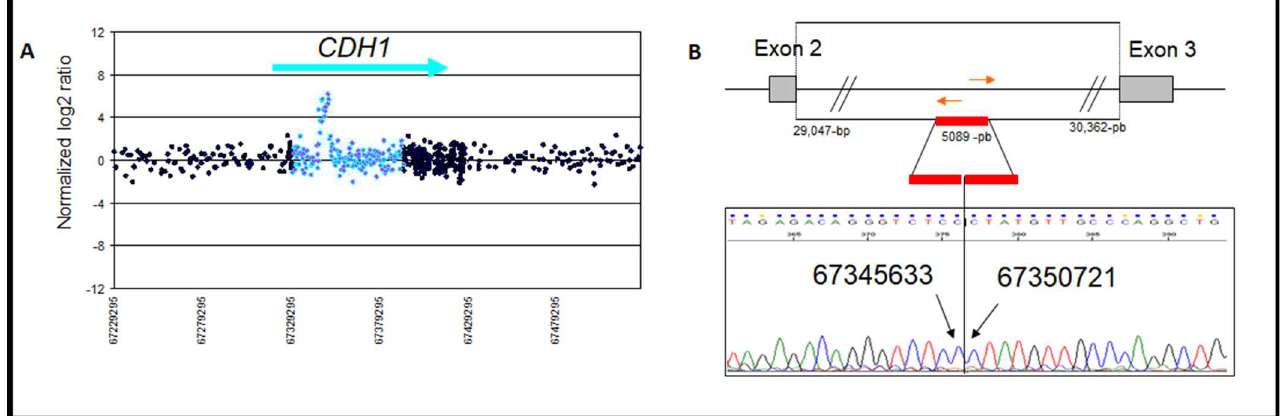
Figure 4. ( A ) Array CGH profiles obtained for the heterozygous intron 2 duplication of the CDH1 gene. Intron 2 is represented in blue dots. ( B ) Sequencing chromatogram of the mapped breakpoint for the intron 2 duplication from chr16: 67,345,633–67,350,721(NM_0043603: c.163+15817_c.163+20905dup). Gray box: exons; red line: duplication locus; red arrows: position of sequencing primers.